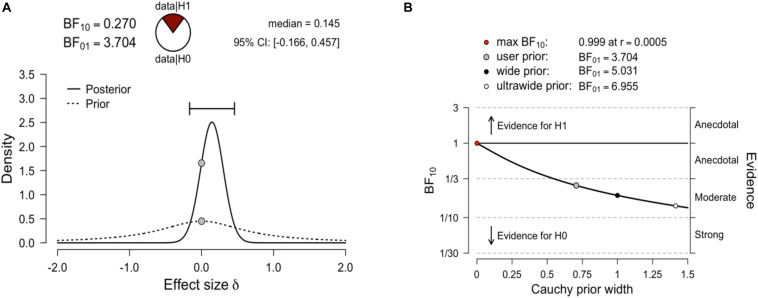
(A) Bayesian independent samples t-test for the effect size δ. The dashed line illustrates the prior distribution (default Cauchy prior centered on zero, r = 0.707), the solid line shows the posterior distribution. The two gray dots indicate the prior and posterior density at the test value. The probability wheel on top visualizes the evidence that the data provide for the null hypothesis (H0: effect sizes are equal) and the alternative hypothesis (auburn, H1: effect sizes are different). The median and the 95% central credible interval of the posterior distribution are shown in the top right corner. (B) The Bayes factor robustness plot. The plot indicates the Bayes factor BF01 (in favor of the null hypothesis) for the default prior (r = 0.707), a wide prior (r = 1), and an ultrawide prior (r = 1.414). All priors suggest moderate evidence for the null hypothesis, which is relatively stable across a wide range of prior distributions. Plots taken from JASP.